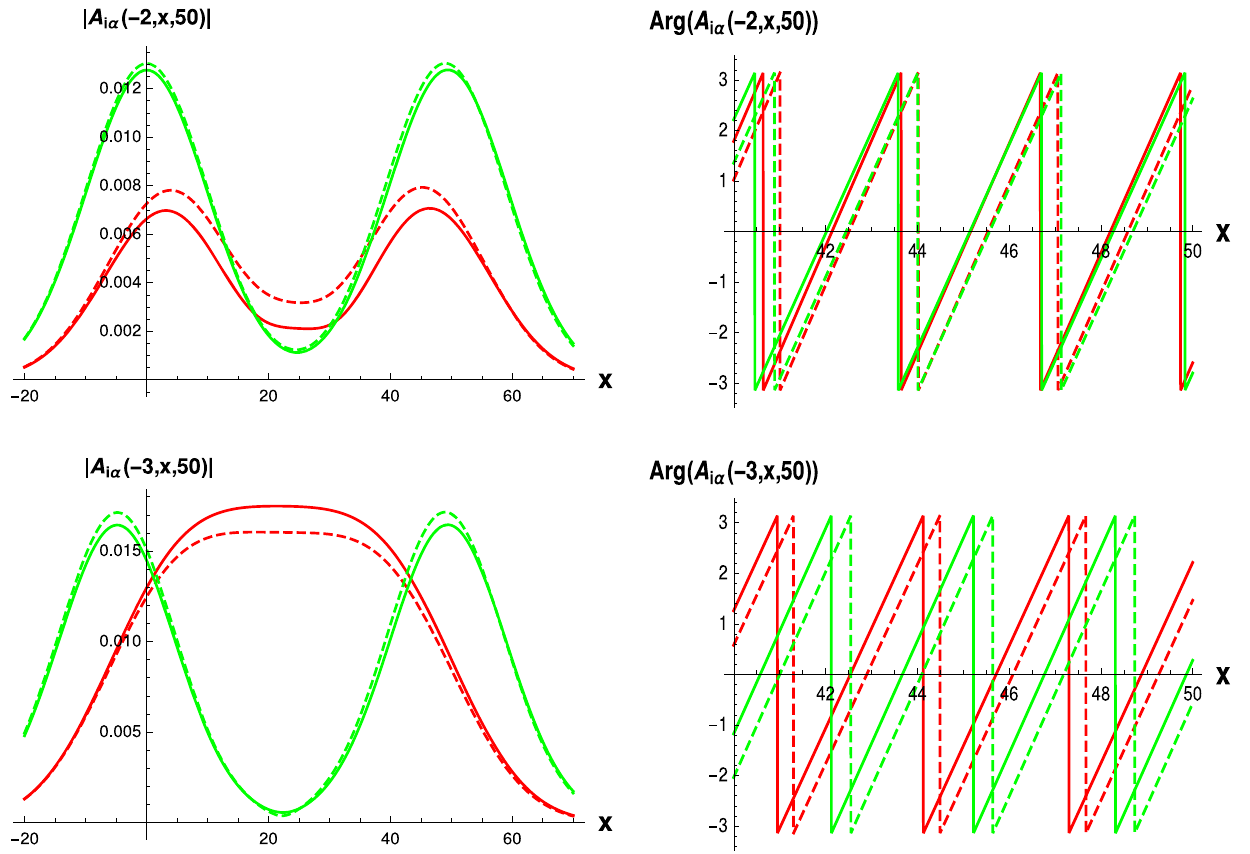
Fig. 6 The absolute value (left) and phase (right) of A i α ( p , x , 50 ) for p = − 2 (top) and p = − 3 (bottom). The neutrino flavors i are 1 (solid) and 2 (dashed). The environmental interaction eigenvalues of 0 (red)